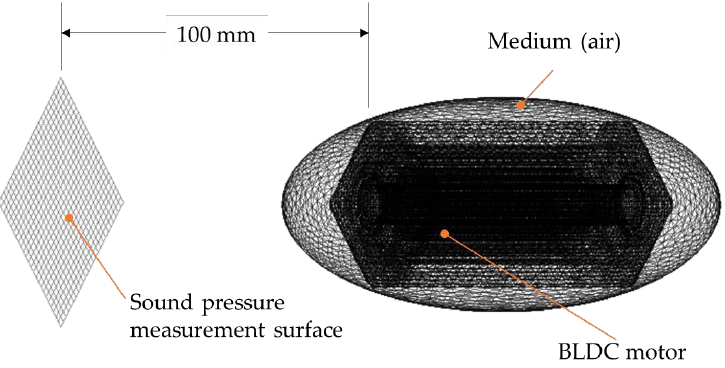
Figure 6. BLDC noise simulation setup.